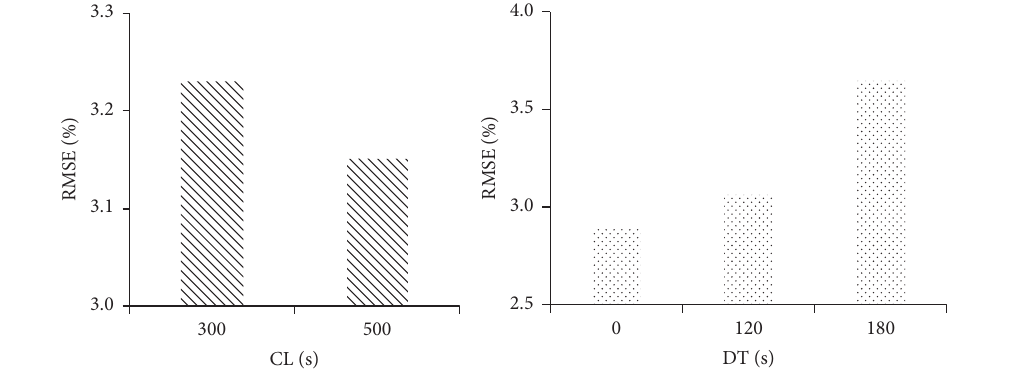
Figure 8: Influence of CL and DT on RMSE of calibration model.